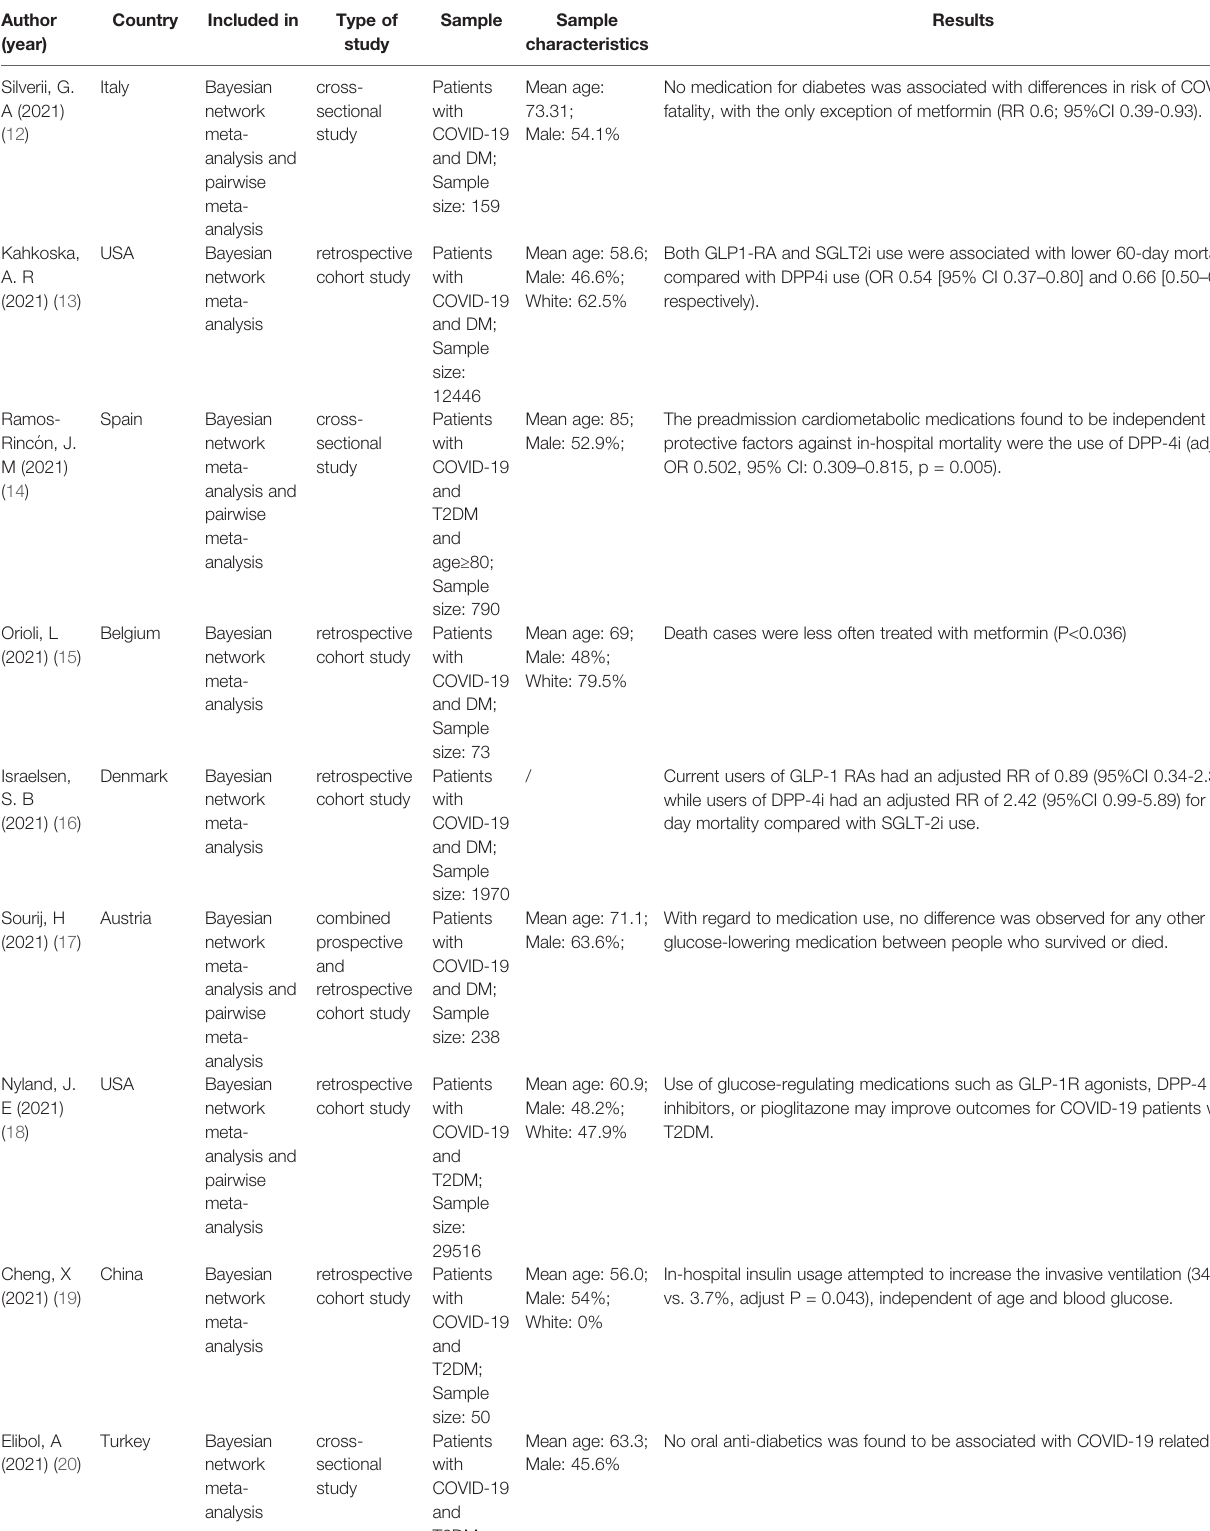
TABLE 1 | Clinical characteristics of the studies included in the